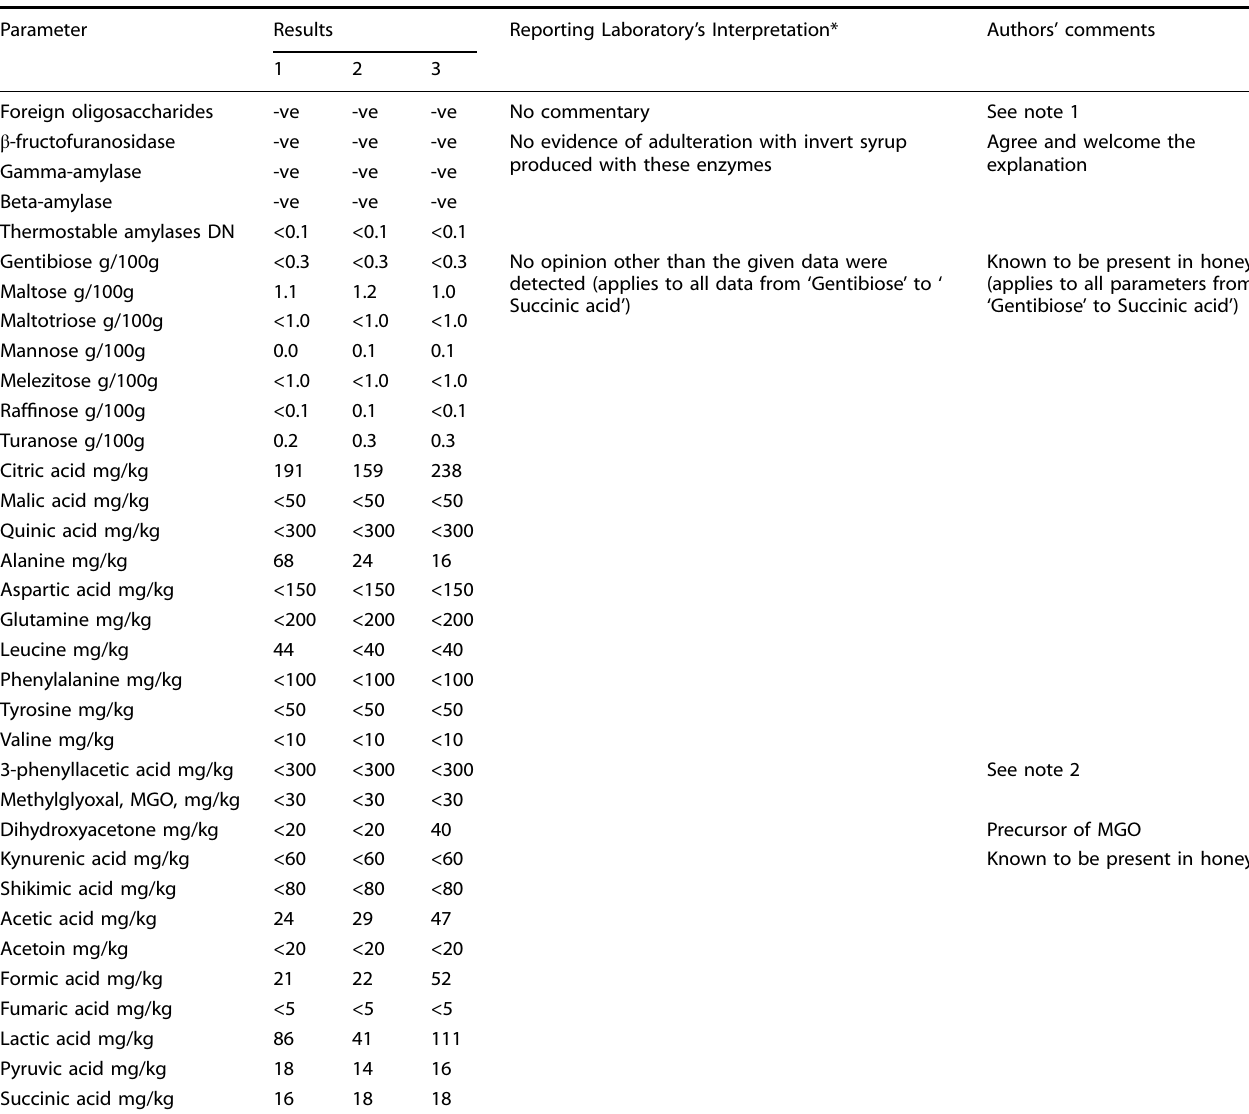
Table 4. Other general